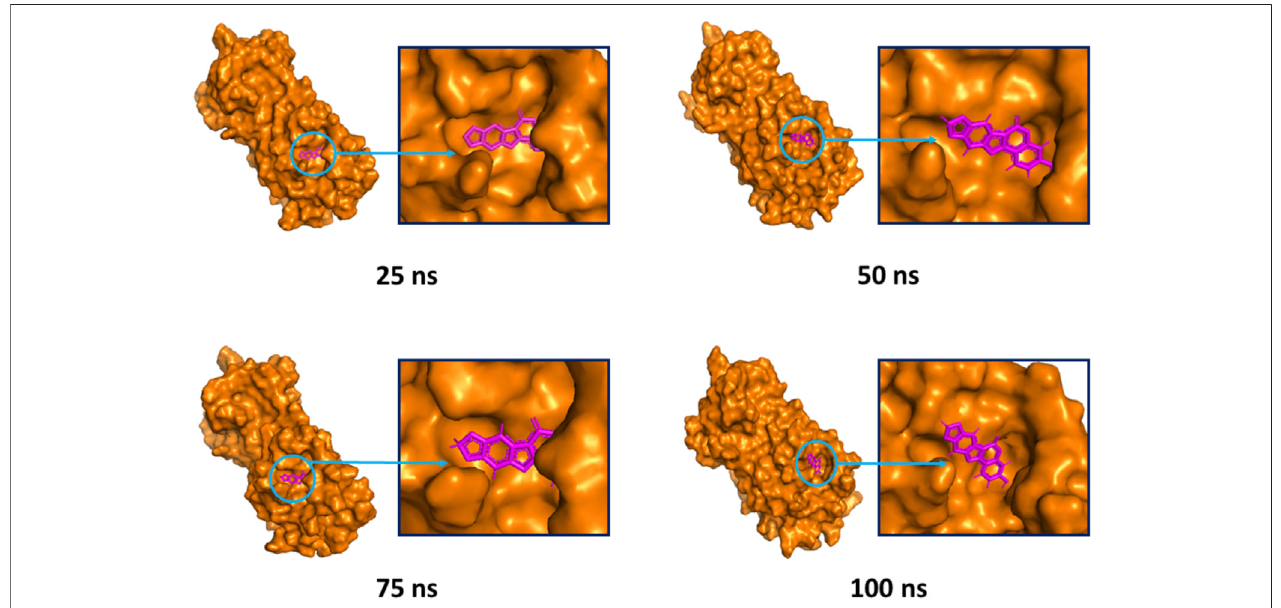
Frontiers in Bioinformatics |